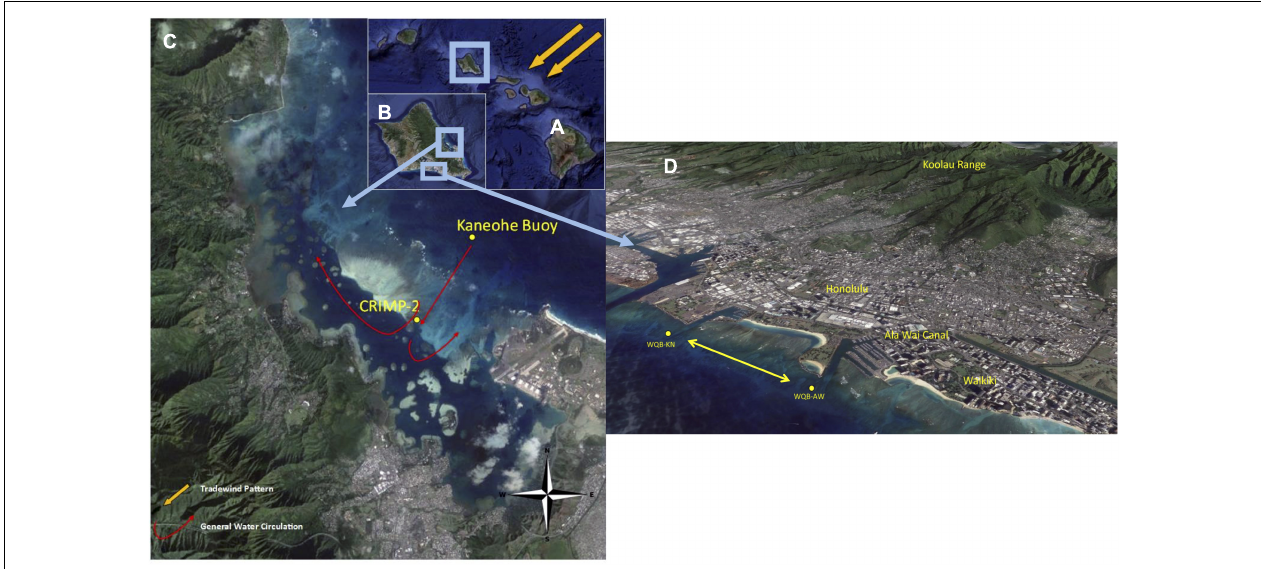
FIGURE 1 | Locations of the four O’ahu coral reef MAPCO 2 moorings. (A) The Hawaiian Islands, highlighting O’ahu. (B) The island of O’ahu, highlighting Kaneohe Bay on the windward (east) coast and the Honolulu watersheds on the southern coast. (C) Kaneohe Bay, with the CRIMP-2 buoy located on the back reef and the Kaneohe buoy on the deeper forereef. The red dot represents the previous CRIMP location. (D) Two south shore buoys, Ala Wai (WQB-AW) and Kilo Nalu (WQB-KN) are located 200 m offshore of urban Honolulu above fringing reefs. WQB-AW is located near the mouth of the Ala Wai Canal, which drains the Honolulu city watersheds. Adapted from Drupp et al.